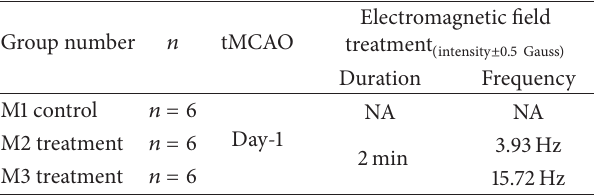
Table 1: Groups and treatment